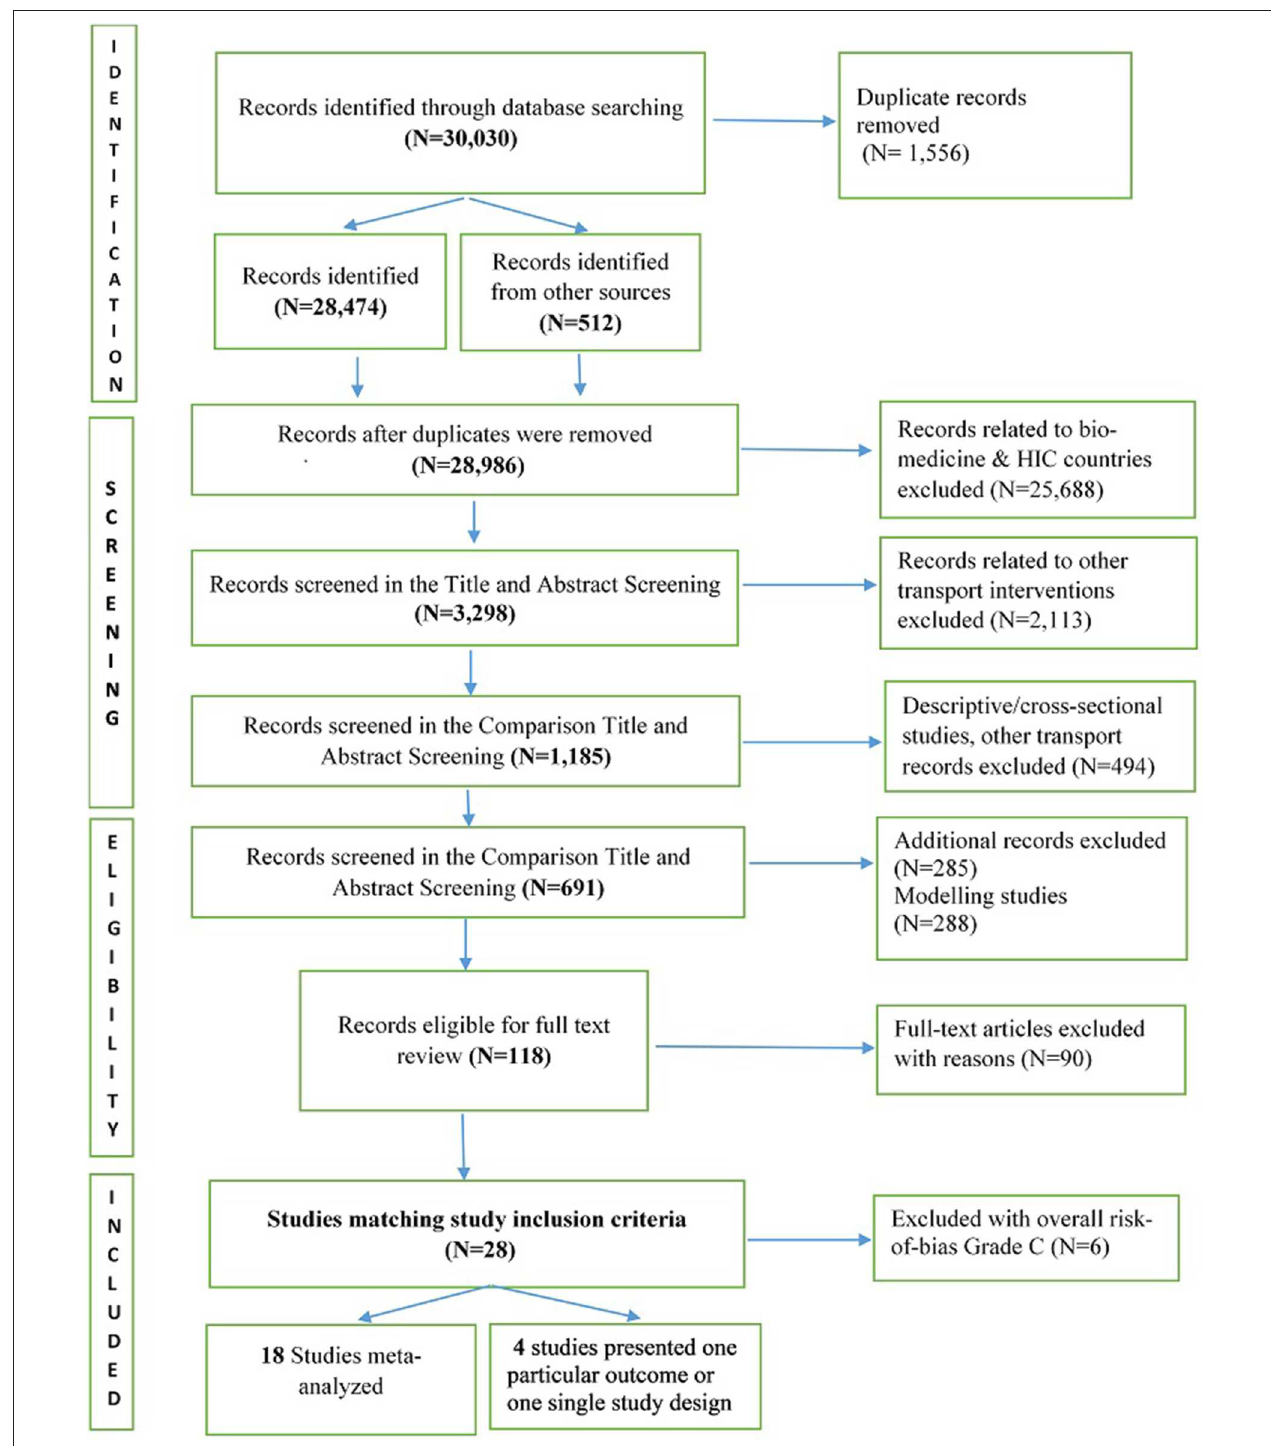
FIGURE 1 | Search flow